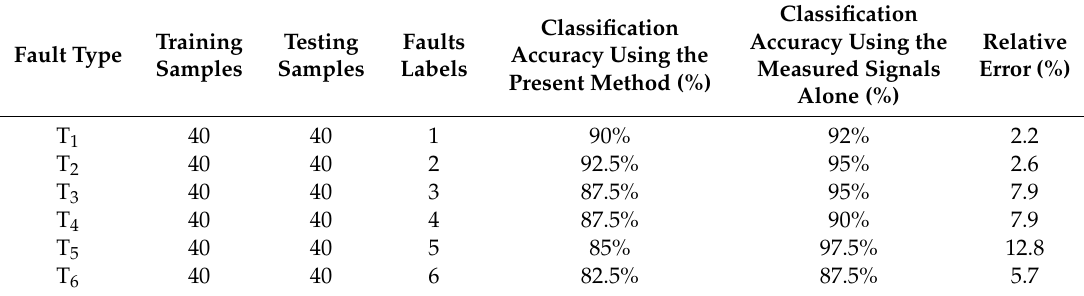
Figure 7. The measured signals with six types of faults: ( a ) Fault type T 1 ( b ) Fault type T 2 , ( c ) Fault type T 3 , ( d ) Fault type T 4 , ( e ) Fault type T 5 , and ( f ) Fault type T 6. Table 5. The classification results using the proposed method (16 indexes) and measured fault signals alone.